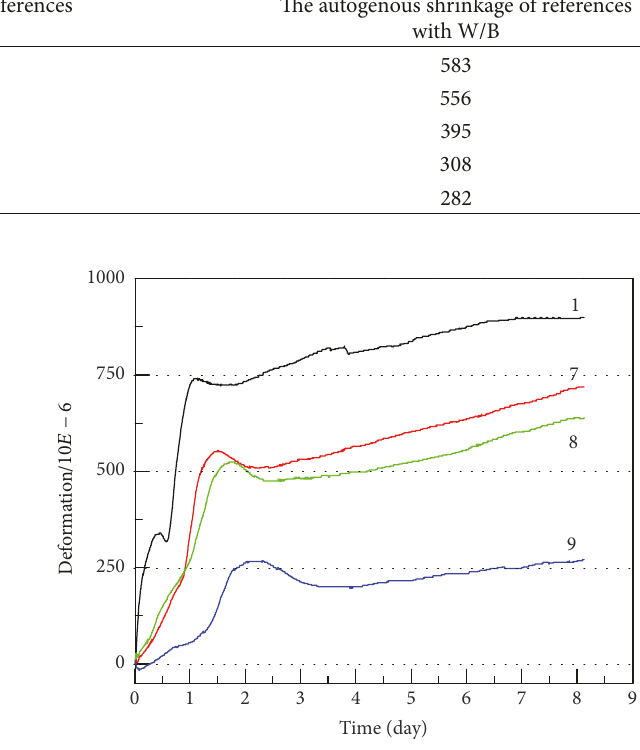
Figure 10: The autogenous shrinkage of references with different W/B.